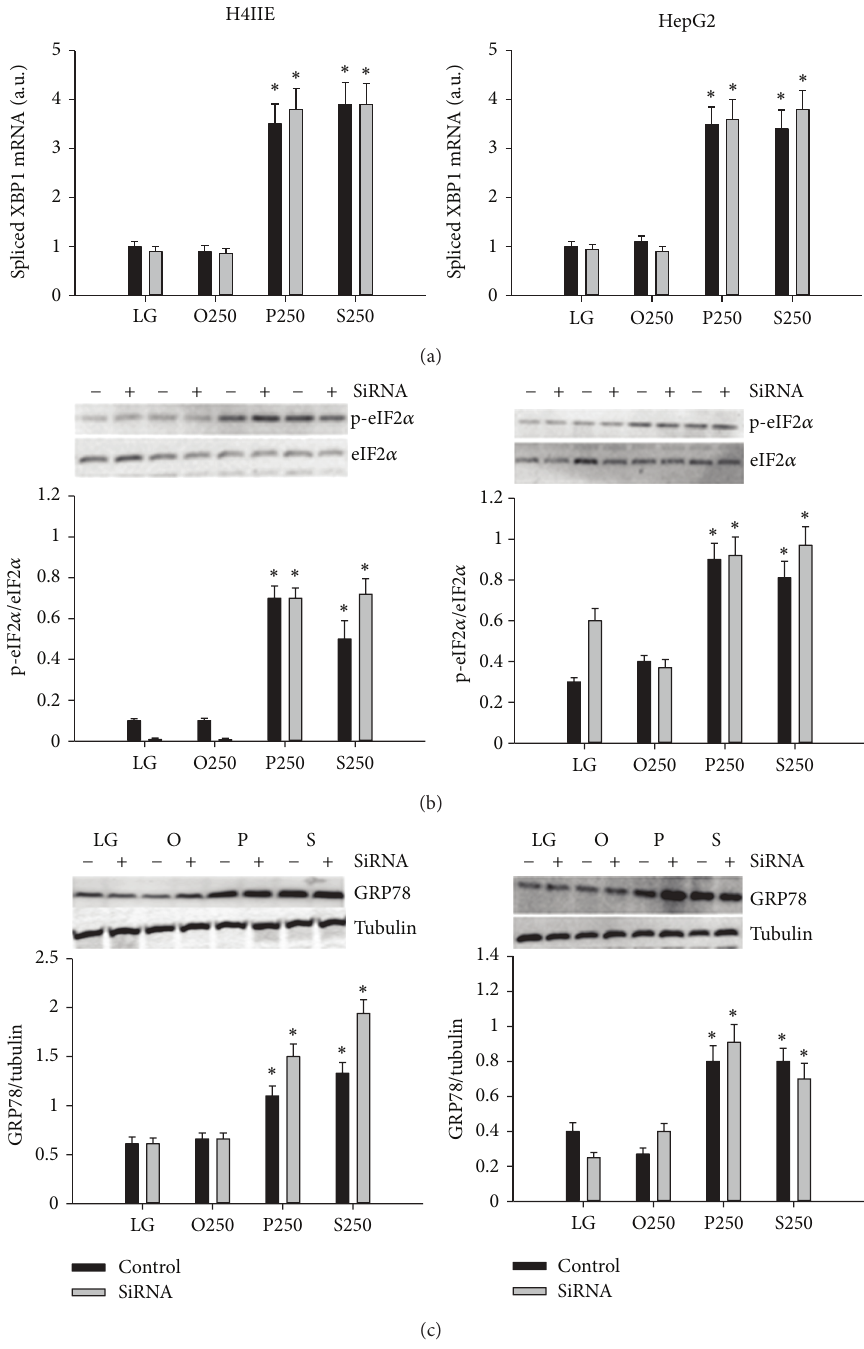
Figure 2: ER stress markers in H4IIE and HepG2 liver cells. XBP1 mRNA splicing (a), phosphorylation of eIF2 𝛼 (b), and GRP78 protein expression (c) in H4IIE (left column) and HepG2 (right column) liver cells following 16h of incubations with control media (LG) or fatty acids (oleate (O), linoleate (L), palmitate (P), or stearate (S)) at 250 𝜇 M in the absence (Control) or presence of PTEN knockdown (SiRNA) ( 𝑛 = 6 ). ∗ : significantly ( 𝑃 < 0.05 ) different from LG and